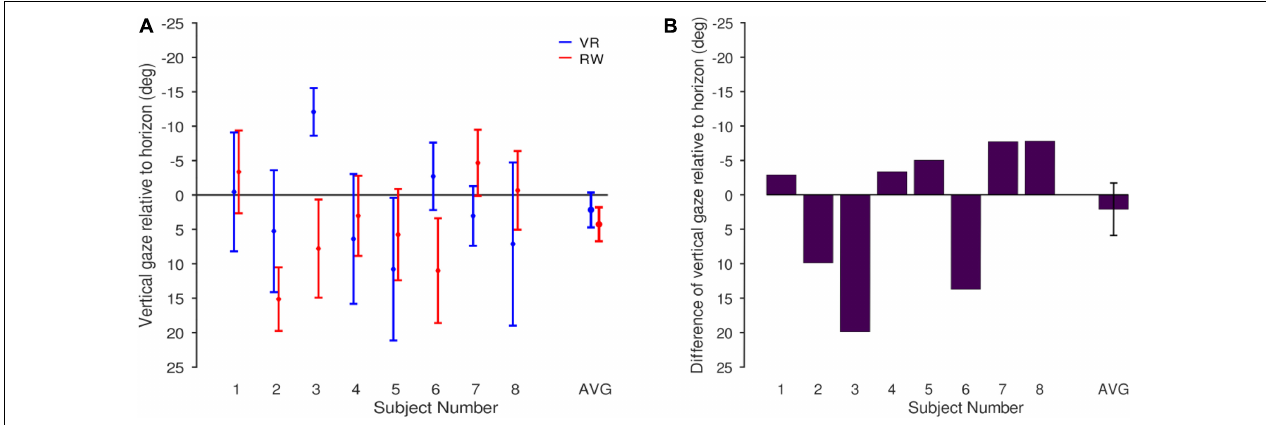
FIGURE 8 | Gaze distribution relative to the horizon for the corridor for which head-in-world direction was determined (the one depicted in Figure 2C , see text). (A) Individual participants (mean and SD) and averaged across participants (mean and SEM). (B) Difference between VR and RW (VR-RW) for each participant and averaged across participants (mean and SEM).